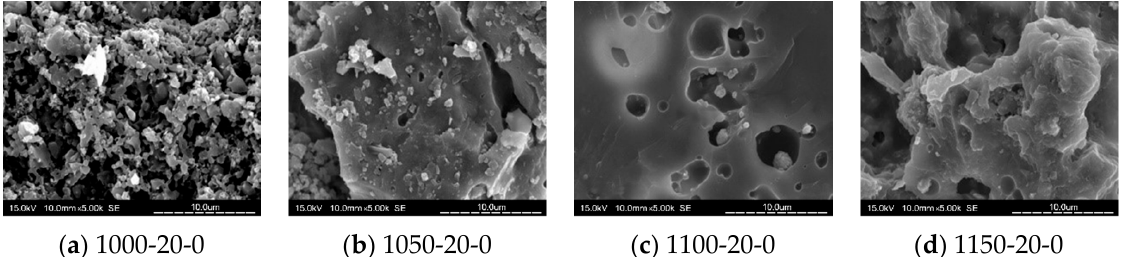
Figure 11. SEM of 20% SSA replacement and no MIBA at different kiln temperatures. ( a ) 1000 °C ‐ 20% SSA ‐ 0% MIBA; ( b ) 1050 °C ‐ 20% SSA ‐ 0% MIBA ; ( c ) 1100 °C ‐ 20% SSA ‐ 0% MIBA ; ( d ) 1150 °C ‐ 20% SSA ‐ 0% MIBA.